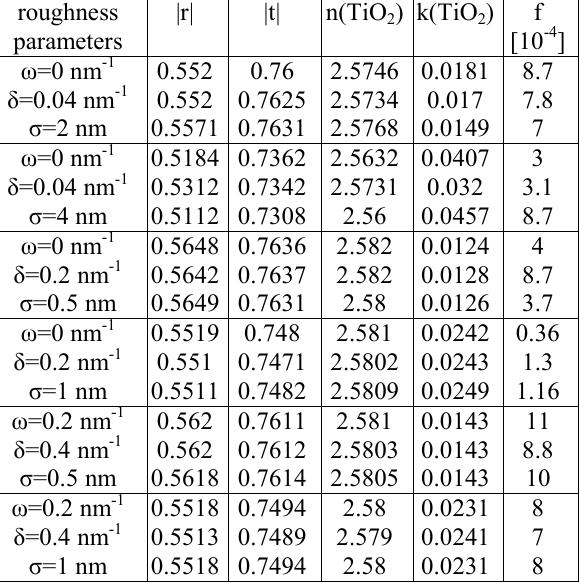
Table 1: Effective parameters evaluation for three- layered structure.